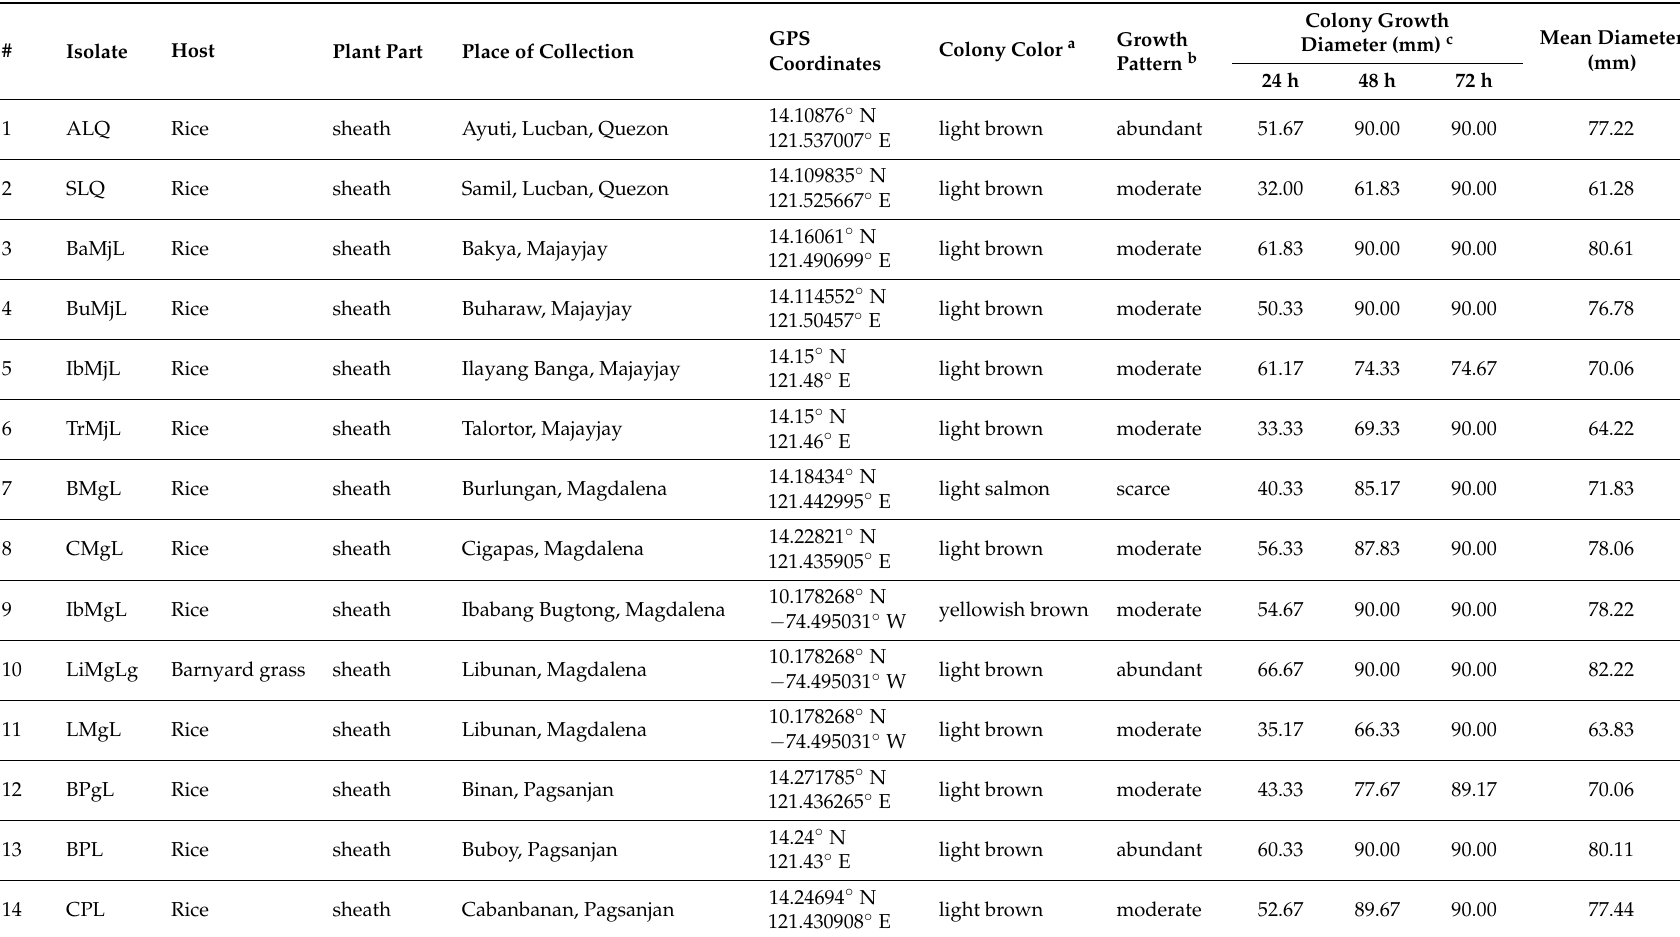
Table 1. Cultural characteristics of Rhizoctonia spp. on potato dextrose agar (PDA) medium. N—north; E—east; W—west; UPLB—University of the Philippines Los